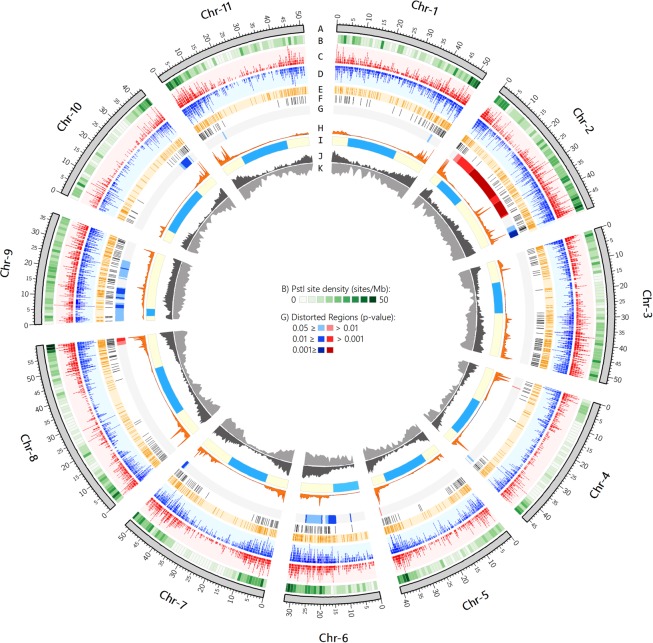
Circos plot depicting the distribution of various genomic attributes along the physical map of the 11 P. vulgaris chromosomes.(A) Physical chromosome (Mb) of common bean. (B) Genome wide heat plot of potential PstI sites detected by in-situ analysis. (C, D) Frequency distribution of Jamapa (blue) and Calima (red) reads obtained through GBS, (y-axis: range 0–160 reads/Mb). (E) Position of GBS-based SNPs identified between parental lines. (F) Physical location of 513 recombinationally unique markers utilized to construct the linkage map. (G) Heat plots highlighting regions with transmission ratio distortions in favor of Jamapa (Blue) or Calima (Red) alleles. (H) Density plot of recombination rate (y-axis: 0–35 cM/Mb). (I) Estimated pericentromeric region (light blue). (J) Density plot of coding sequences (CS) along chromosomes (y-axis: 0–178 CS). (K) Frequency distribution of genome-wide in-situ identified SNPs between Jamapa and Calima (y-axis: 0–2000 SNPs).